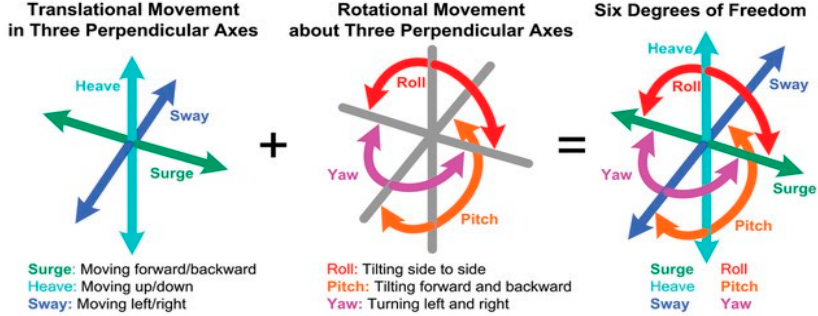
Figure 4. Possible movements for robot manipulators (sensing.honeywell.com).